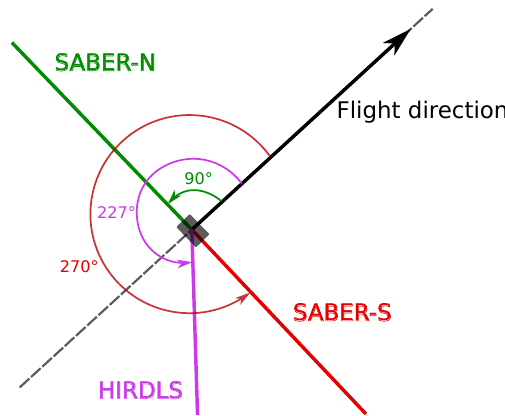
Figure 2. Satellite top-view of the SABER and HIRDLS viewing geometry, the black arrow shows the flight direction, green and red lines are the lines of sight (LOS) of SABER for northward- and southward-viewing modes, respectively. The purple line is the LOS of HIRDLS. For details, see